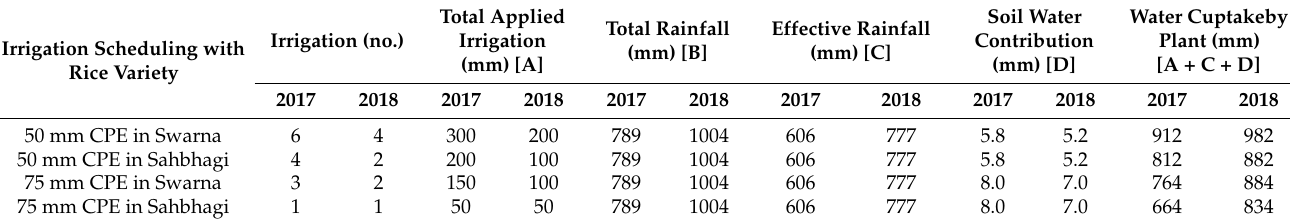
Table 3. The number of irrigations and total water consumed by the plants under different irrigation levels along with various rice